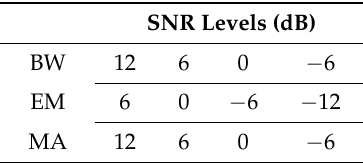
Table 3. SNR magnitudes for noise, baseline wander (BW), electrode movement (EM) and muscle artifact (MA).